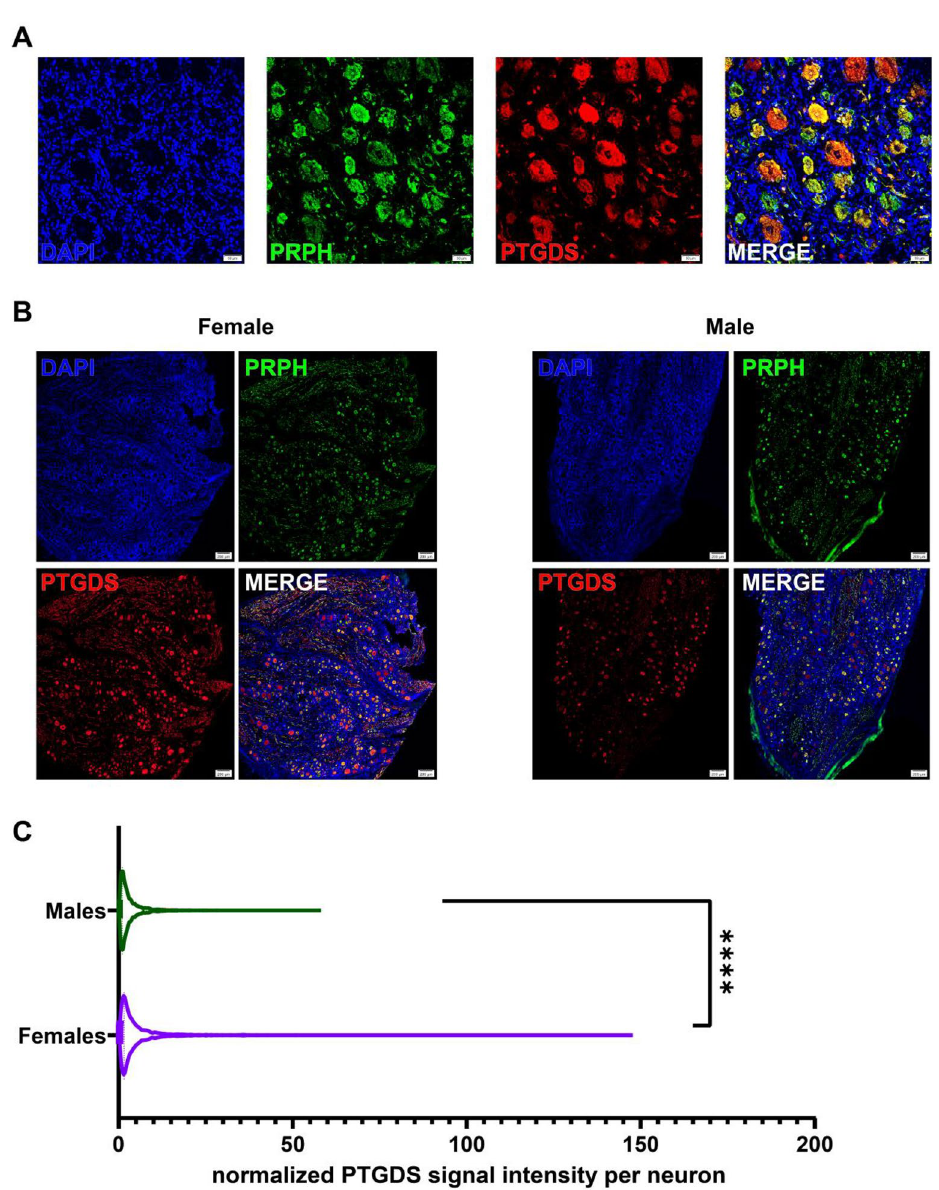
Figure 3. PTGDS is expressed in human DRG neurons. ( A ) Confocal images show co-localization of PTGDS (red) and neuronal marker peripherin (PRPH, green). Cell nuclei are labelled with DAPI (blue). Scale bar = 50 µm. ( B ) Expression of PTGDS in female (left) and male (right) DRG neurons. Scale bar = 200 µm. ( C ) PTGDS has higher expression in female DRG neurons compared to male DRGs (Unpaired t test with Welch’s correction, t = 11.08, df = 4299, p-value < 0.0001). ****p-value < 0.0001. Signal intensity was normalized by the area of the neurons. Data from donor #12 was excluded (post-menopause, 61-year-old female). In total 6813 neurons were analyzed (2920 from 5 female DRG samples and 3893 from 6 male DRG